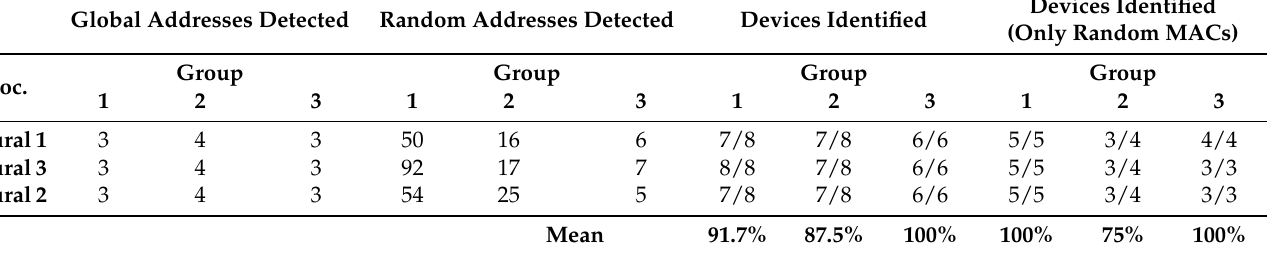
Table 5. MAC de-randomization results for groups of devices for the rural environment.